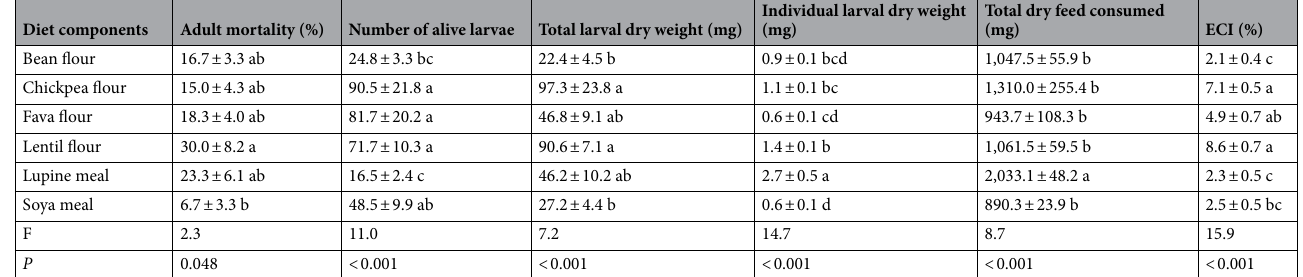
Table 5. Adult mortality (%) (after 1-week), number of alive larvae, total larval dry weight (mg), mean individual larval dry weight, total dry feed consumed (mg), and efficiency of ingested food conversion (ECI, %) of Tenebrio molitor larvae fed on different legume flours for 10 weeks. In all cases, values represent means ± SEM (n = 6). Within each column, means followed by the same lowercase letter are not significantly different (in all cases df = 5, 29; Tukey–Kramer HSD test at P = 0.05).